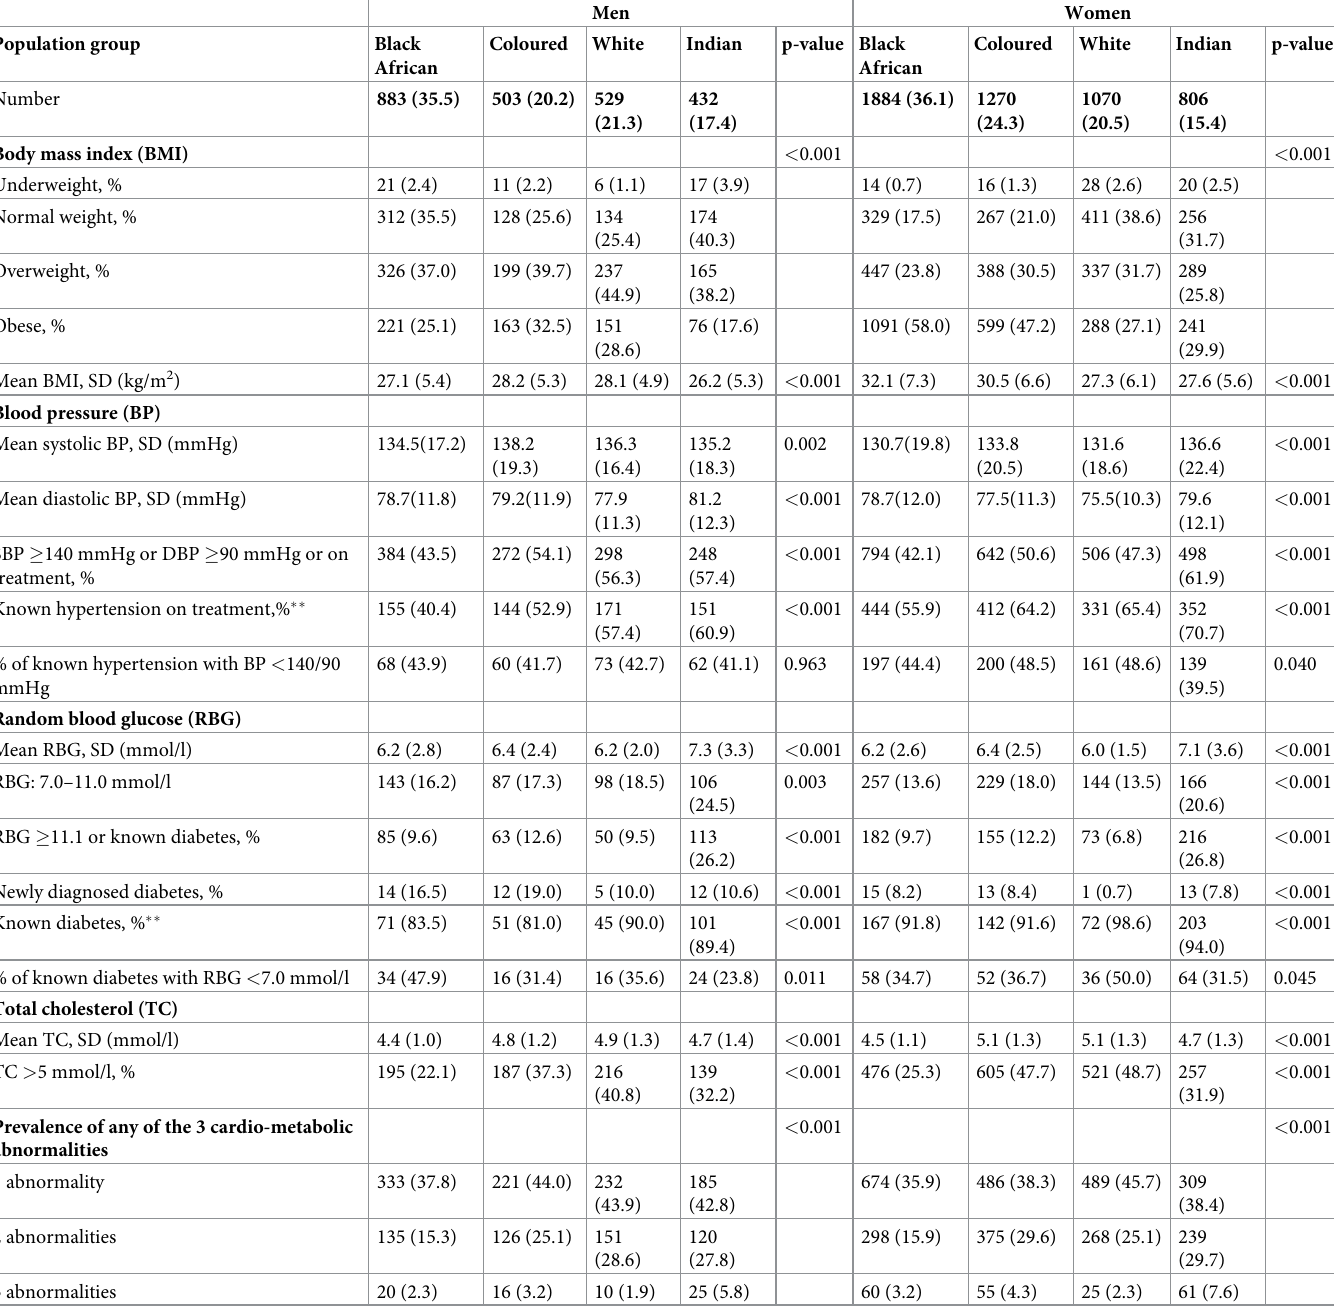
Table 2. Cardio-metabolic risk factors presented by population group and gender (cid:3) .